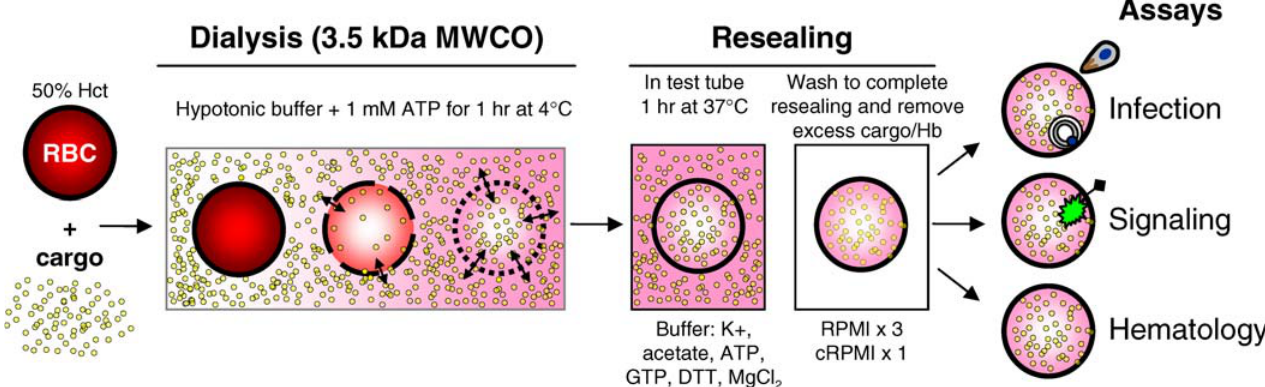
Figure 1. Schematic for the Production of Ghosts with G s Signaling and Malarial Infection that Closely Mimic Normal Erythrocytes Erythrocytes were washed and resuspended to 50% Hct in PBS-glucose containing proteins of interest ( ‘‘ cargo, ’’ yellow spheres) as described in Methods. The cell suspension was dialyzed against ATP-supplemented hypotonic potassium buffer, lysing cells, and allowing exogenous cargoes to enter and endogenous cytoplasmic proteins to exit lysed cells (depicted over time as increasing extracellular hemoglobin, change in cell color from red to pink, and loss of membrane integrity). Lysed cells were removed to cold test tubes and resealed at 37 8 C for 1 h and washed three times in RPMI and once in RPMI supplemented with 10% human serum (cRPMI) to eliminate extracellular hemoglobin, cargo, and buffer (see Methods). Ghosts prepared in this manner were subsequently characterized in hematological, signaling, and malarial infection assays, as described in Figure 2.